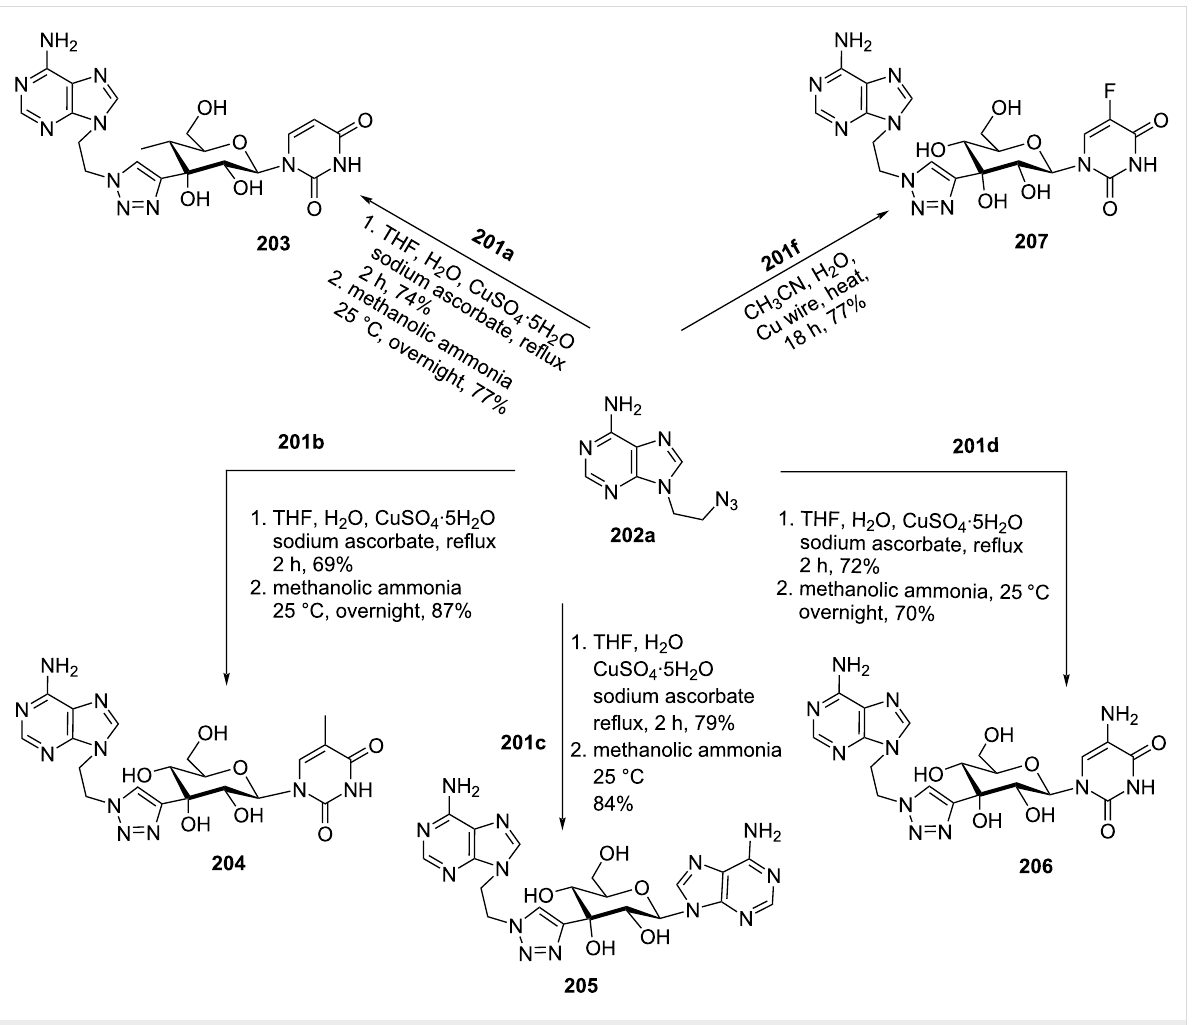
Scheme 53: Synthesis of 3 ′ - C -(1,4-disubstituted-1,2,3-triazolyl)-double-headed pyranonucleosides 203 – 207 .